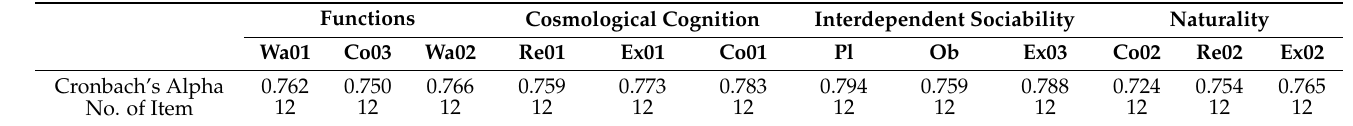
Table 8. Reliability test results of the research instrument based on local spatial qualities and indicators.